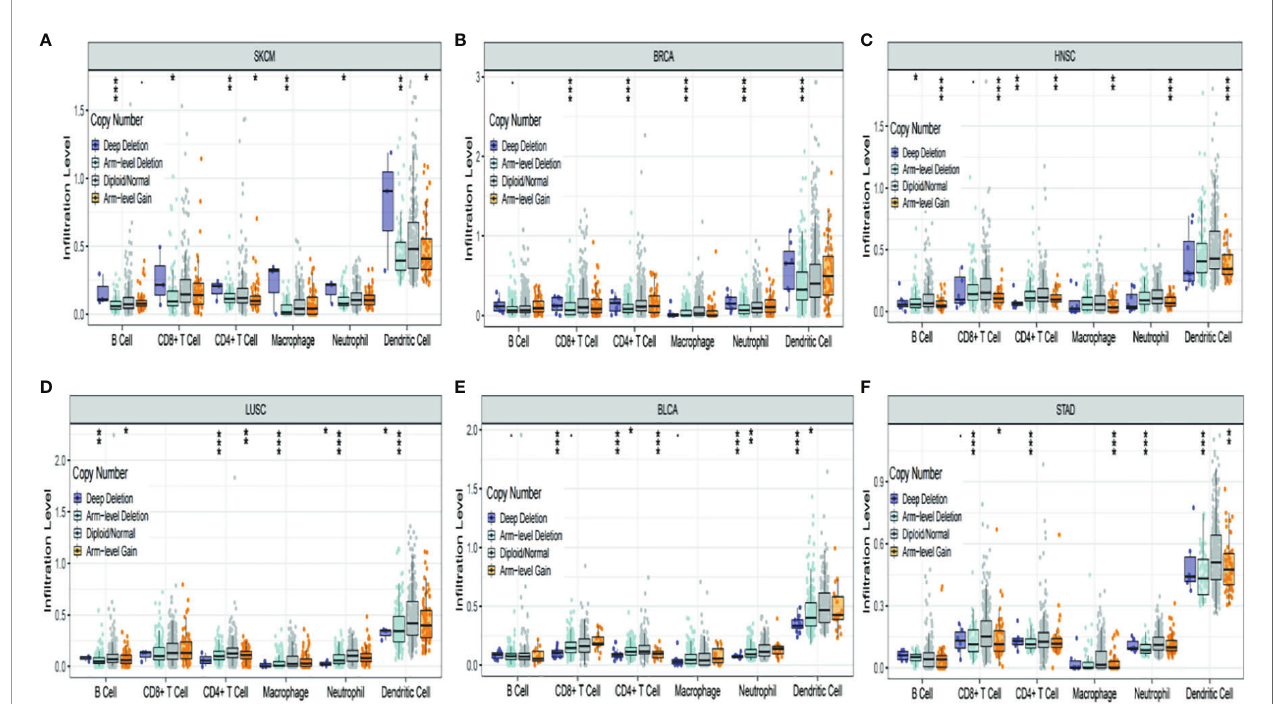
FIGURE 7 | Association between TRPM8 copy number variation and immune in fi ltrates in (A) SKCM (skin cutaneous melanoma), (B) BRCA (breast invasive carcinoma), (C) HNSC (head and neck cancer), (D) LUSC (lung squamous cell carcinoma), (E) BLCA (bladder urothelial carcinoma), and (F) STAD (stomach adenocarcinoma). *P < 0.05, **P < 0.01, ***P <